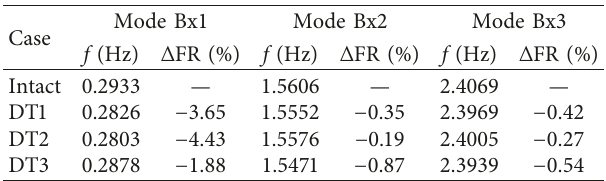
Table 9: Natural frequencies of along-wave bending modes: damage type 1.